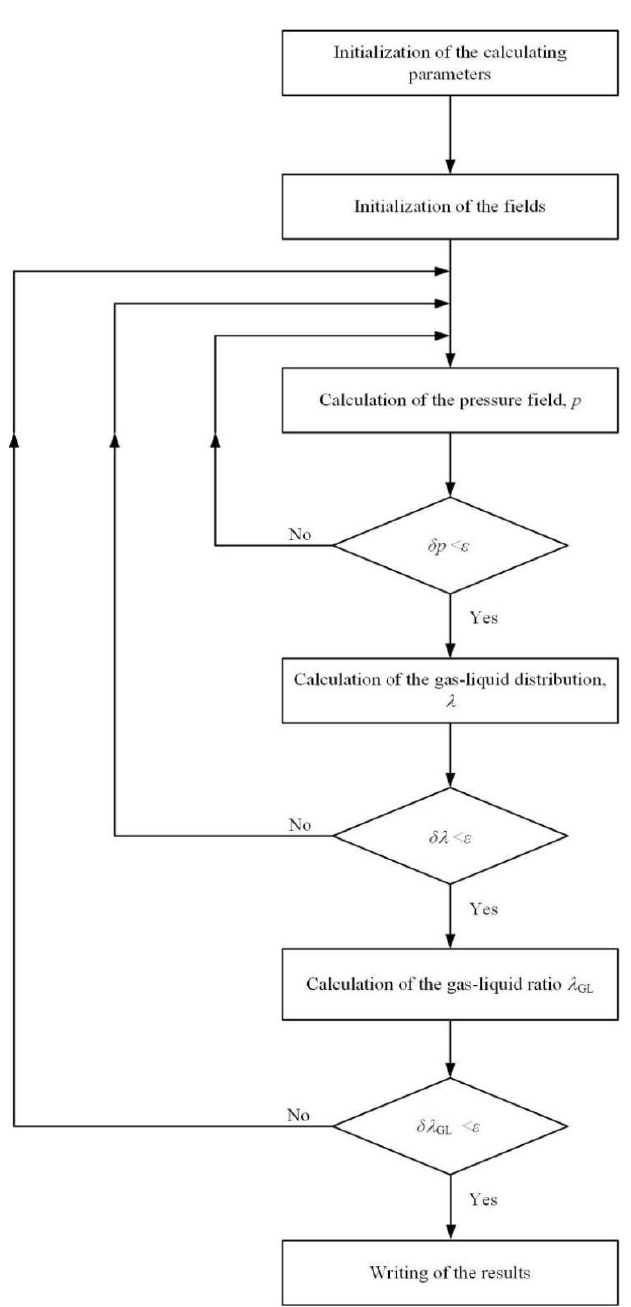
Figure 2. Flowchart of the numerical procedure.